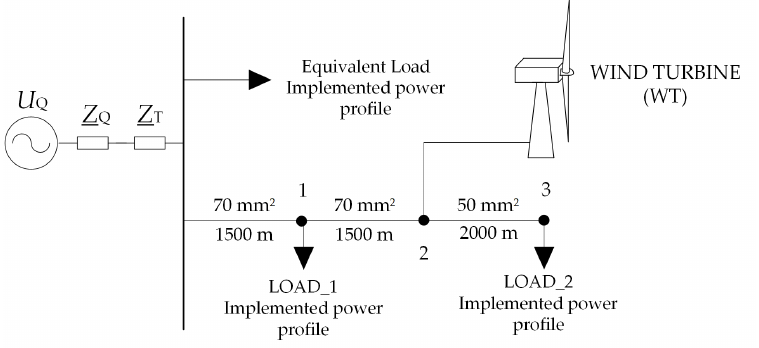
Figure 11. Diagram of the analyzed medium volatges distribution line with a wind